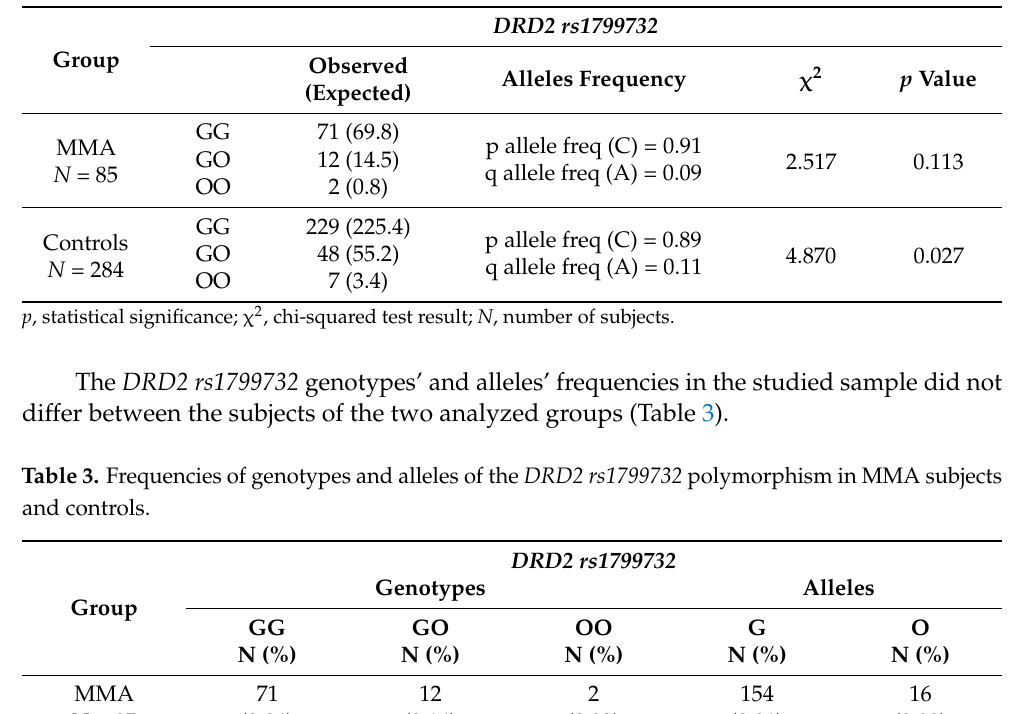
Table 2. Hardy-Weinberg equilibrium of the DRD2 rs1799732 in group of MMA subjects and controls.